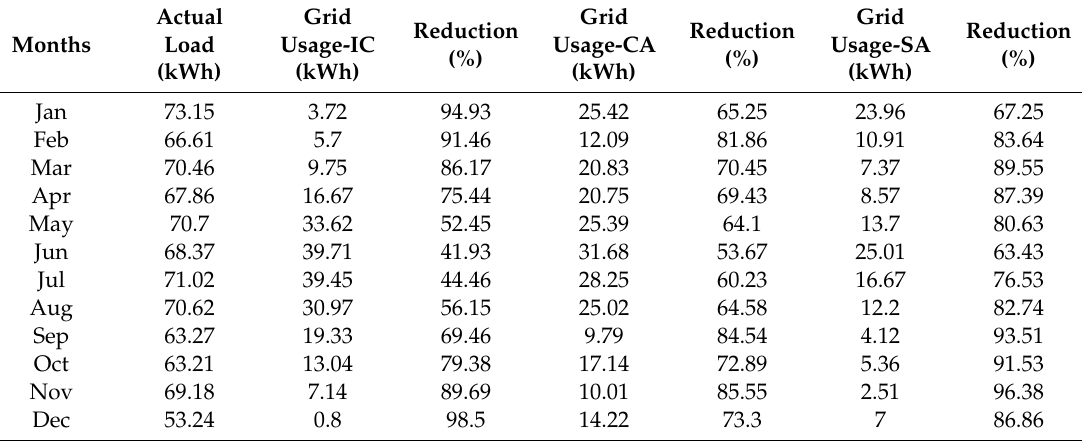
Table A3. Monthly grid usage reduction for CP load using three strategies at Gen